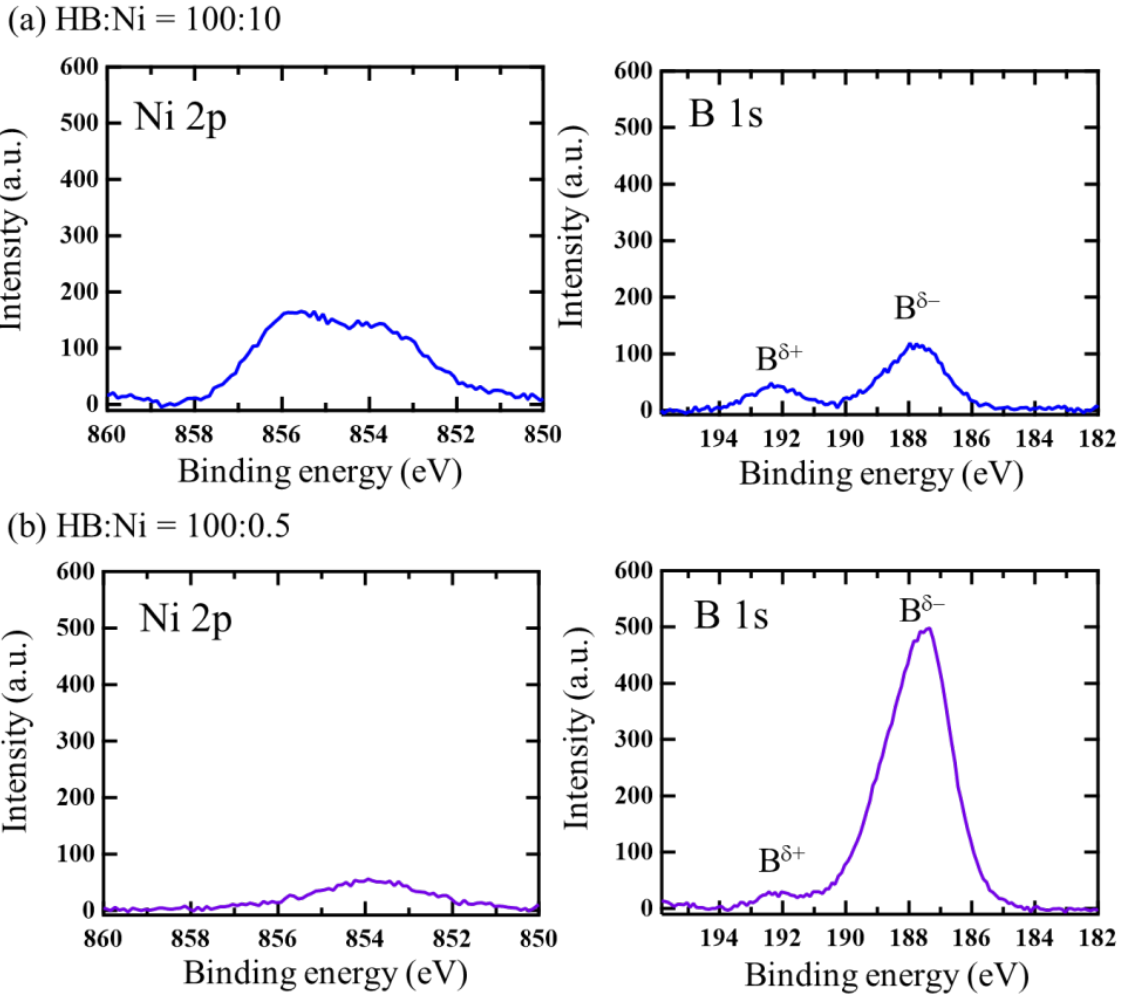
Figure 2. XPS results of the sample after drying the following mixtures in acetonitrile: ( a ) HB:Ni = 100: 10, and ( b ) HB:Ni = 100:0.5. Table 1. Analyzed results of XPS spectra. Atomic Ratio Estimated B 1s Peak Sample from Peak Area